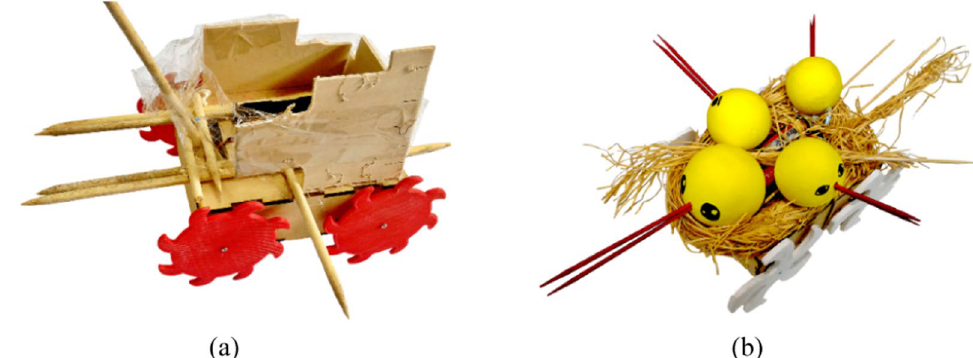
Fig. 4 Comparison of the elaboration/synthesis of the design works of a high school students and b college first‑year students